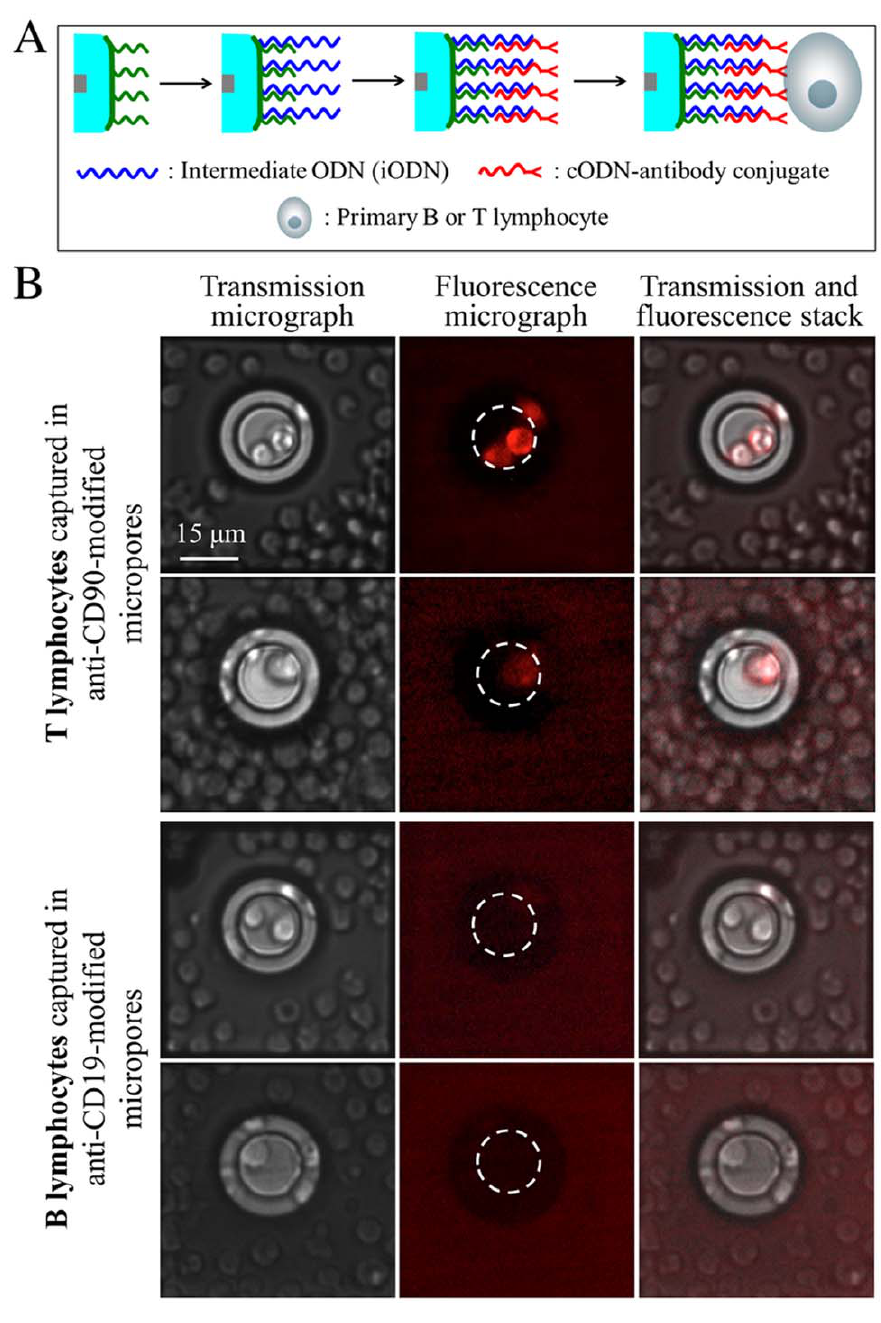
Figure 4. Selective capture of B or T lymphocytes from primary splenocyte samples using specific antibody-functionalized micropores. Only the T lymphocytes are fluorescently labeled. A. Schematic illustration of micropore functionalization with antibodies targeting cell surface proteins. B. Transmission and fluorescence microscopy images of cells captured in antibody-functionalized micropores, and stacks of the images. The white dashed circles in the fluorescence images indicate the position of the micropore wall.